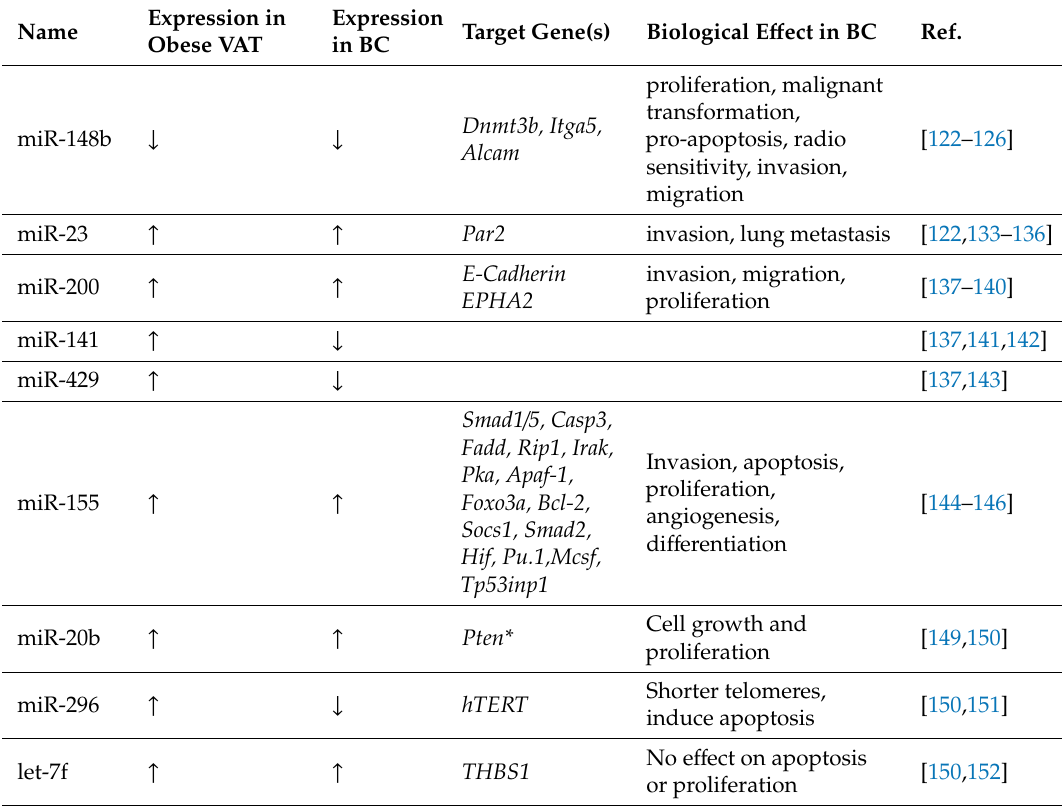
Table 2. List of microRNAs with di ff erential expression in obese VAT versus normal VAT and in BC tissue versus normal